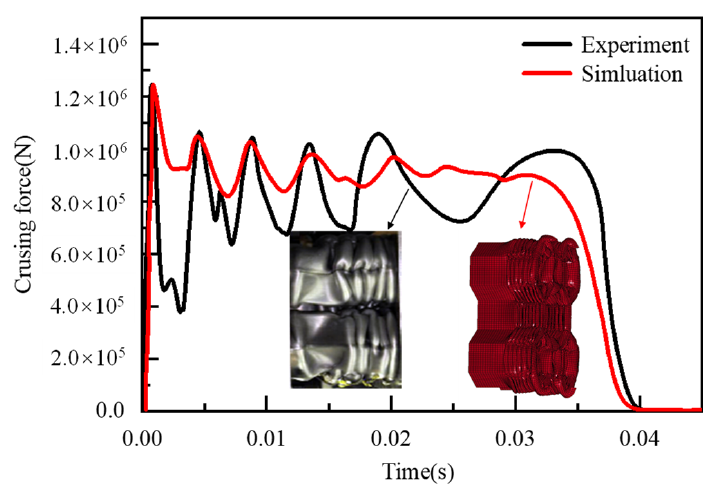
Figure 5. The force–time history curves of experiment and simulation.